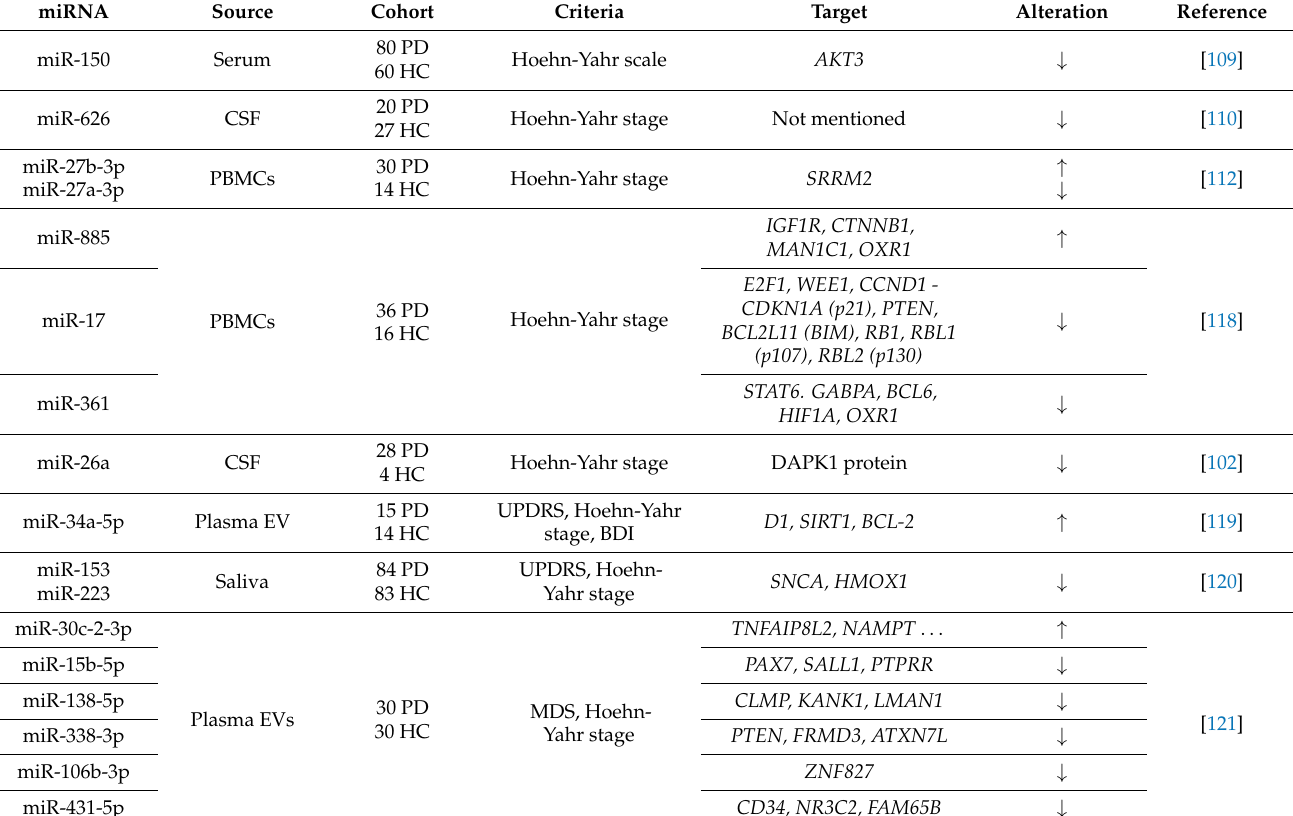
Table 2. Profile of miRNAs proposed as Parkinson’s disease